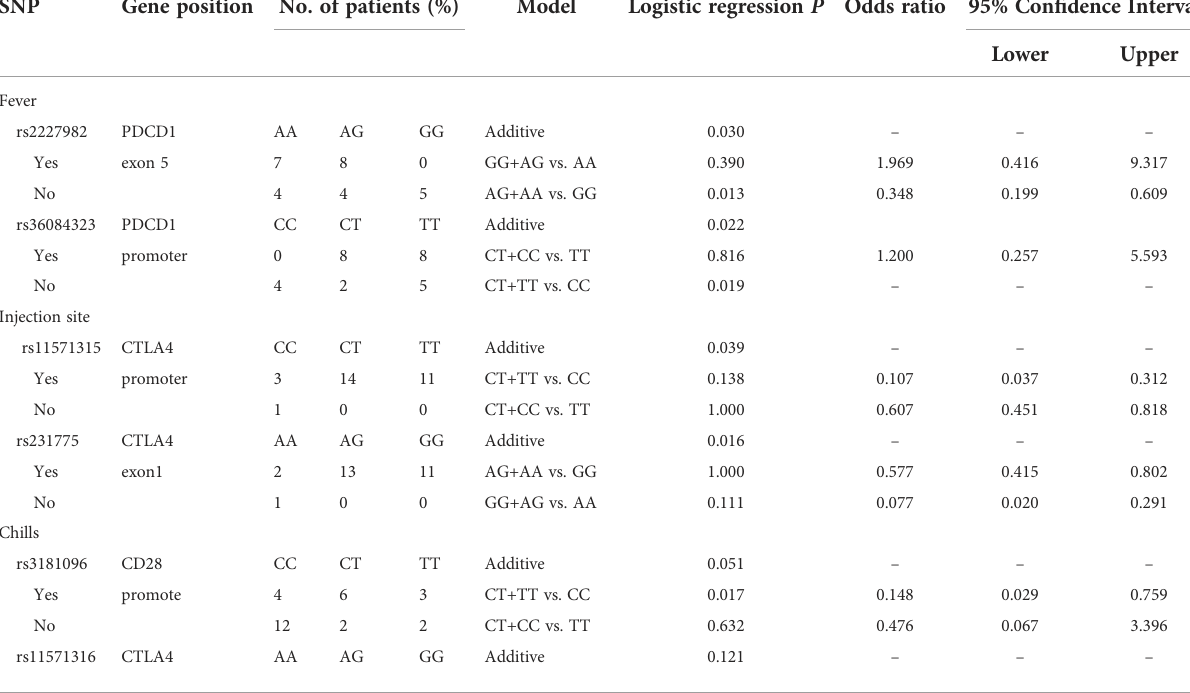
TABLE 4 Side effects with the second dose of mRNA vaccine (Moderna